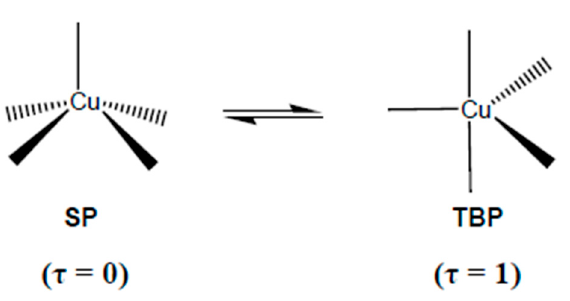
Figure 3. Topological transformation between square pyramidal (SP) and trigonal bipyramidal (TBP) geometries.